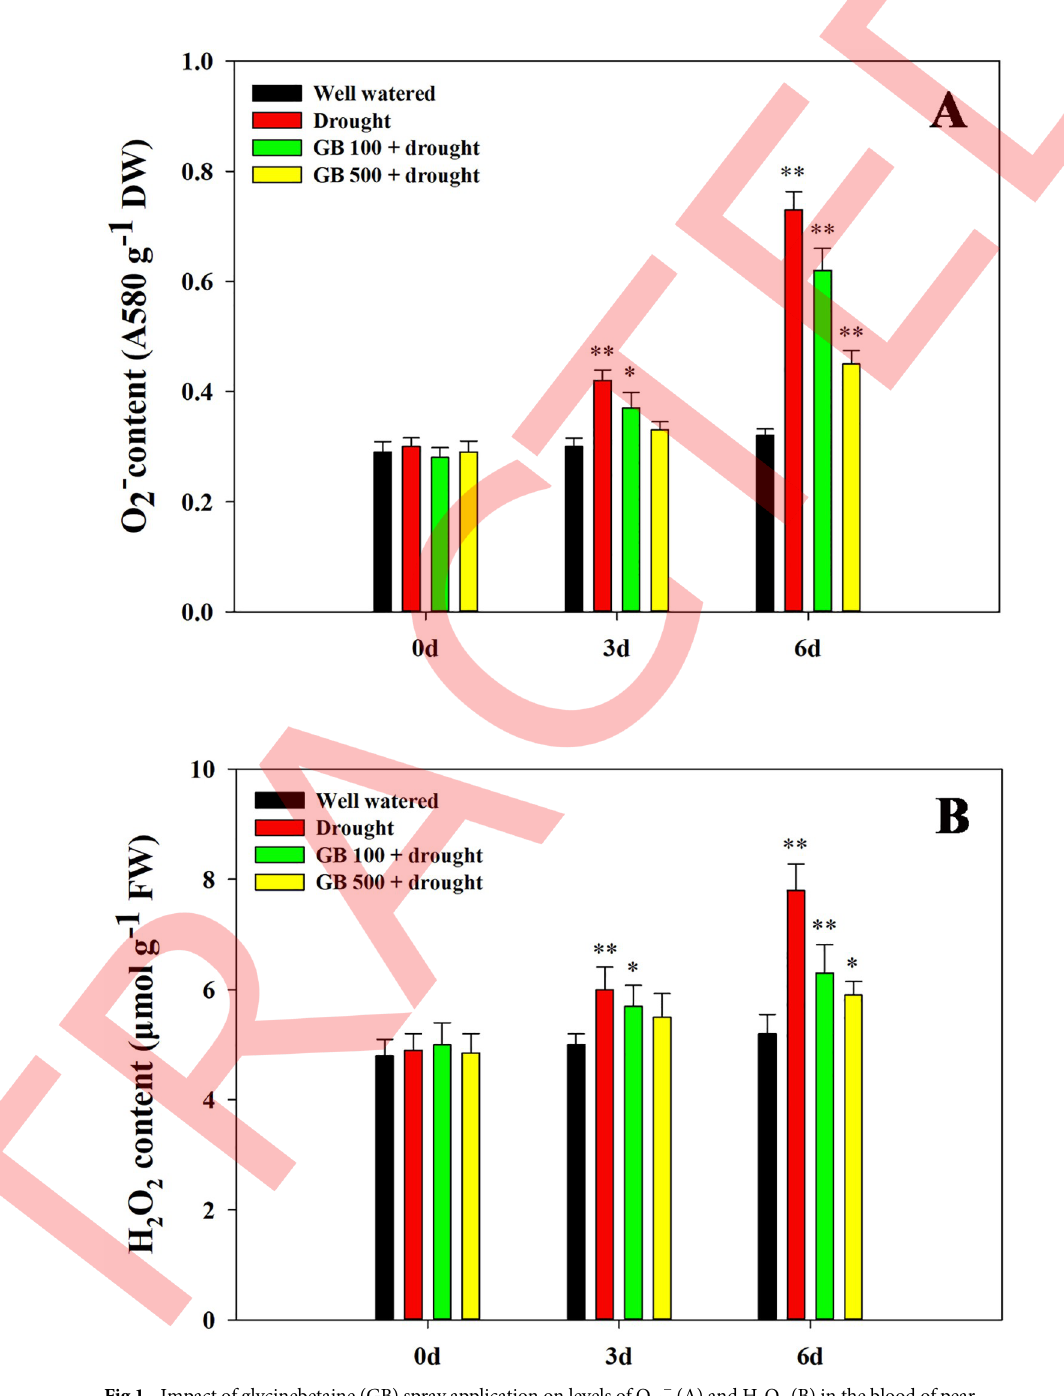
Fig 1. Impact of glycinebetaine (GB) spray application on levels of O 2 � − (A) and H 2 O 2 (B) in the blood of pear planting under drought-related stress conditions. On the day of water preservation, the foliage of pear plants was sprayed with a GB solution of 0 (Drought), 100 (GB 100 + drought) or 500 mg L − 1 (GB 500 + Drought). The same volume of water was added to well-watered plants. On the third and sixth days of the GB foliar spray (or water retention), soil water levels and leaf water capacity culminated in both the "dryness" and the "GB + drought" classes undergoing mild and severe drought tension. Asterisks demonstrate considerable variations from watery plants ( � P < 0.05, �� P < 0.01, Student 0 s t -test). Six replicates are shown as the mean ± SD.